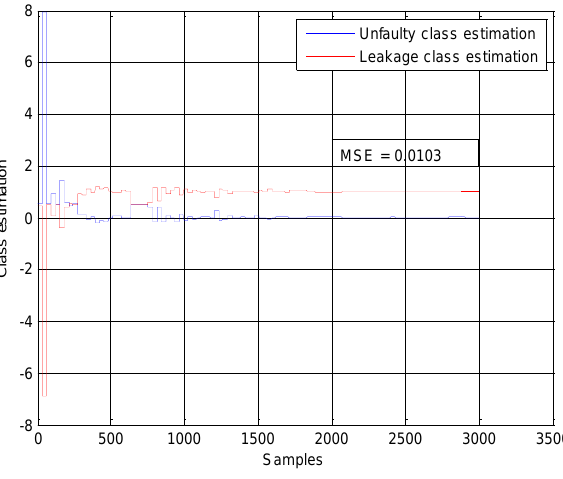
Figure 2. Engine_speed = 1000 rpm and torque = 110 Nm.